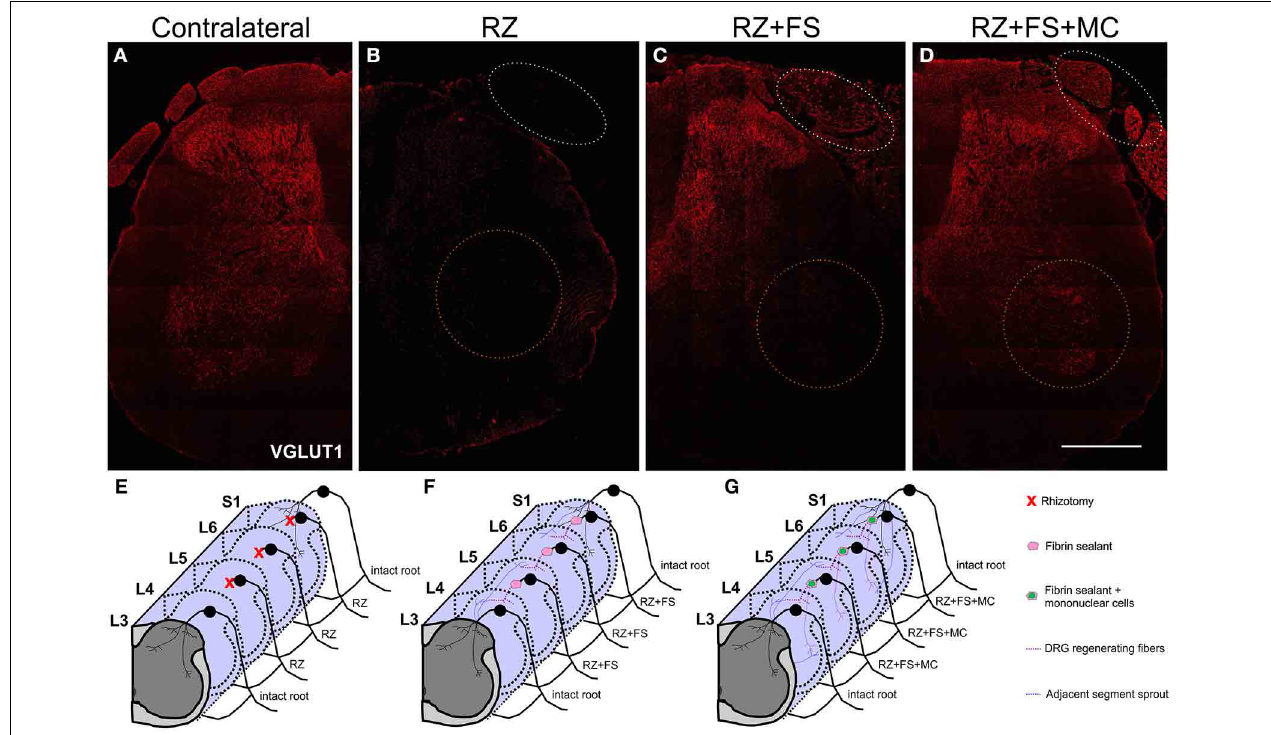
FIGURE 10 | (A–D) Immunohistochemistry for VGLUT1. (A) Contralateral side. (B) IL side of RZ alone group. (C) IL side of RZ + FS group. (D) IL side of RZ + FS + MC group. White dotted ellipse represents the injury/reimplantation site. Orange dotted circle represents lamina IX. (E–G) Schematic